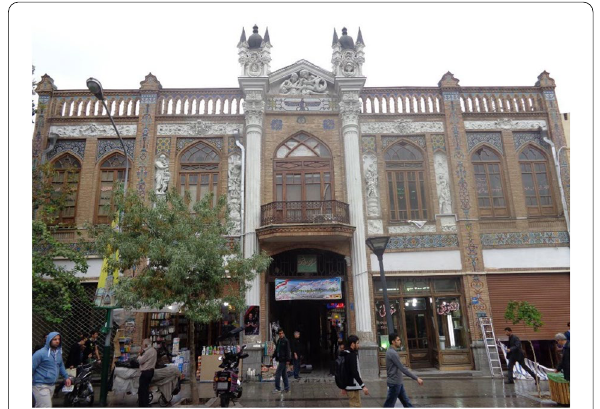
Fig. 1 The urban facade building of the late Qajar period in Tehran, Naser Khosro